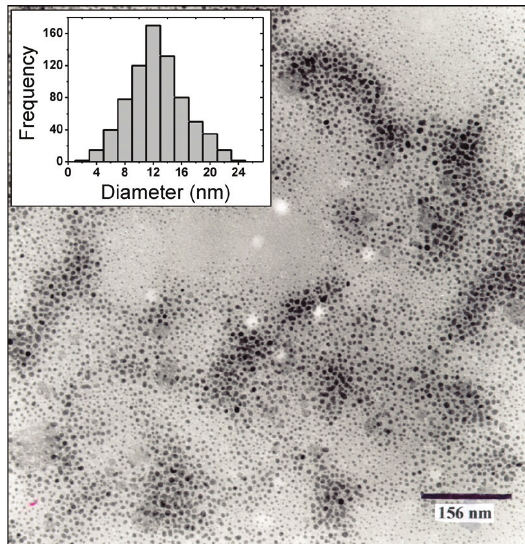
Figure 3. Transmission electron micrograph of the synthesized ferrofluid (77500X). The inset shows the histogram of size distribution of MNP which was obtained from TEM data to approximate a log-normal distribution with mean diameter <D > = 12.6 nm with typical width s = 0.2. P P